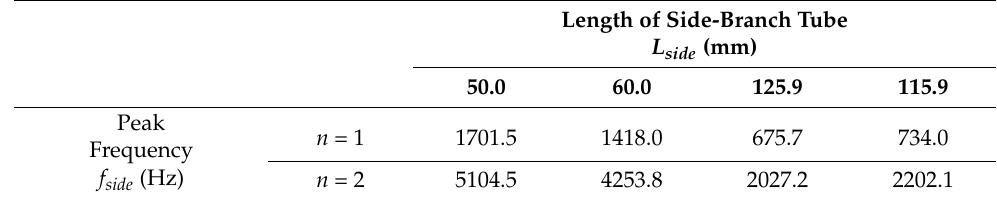
Table 4. Peak frequency of the side-branch silencer sound attenuation at each branch tube length.